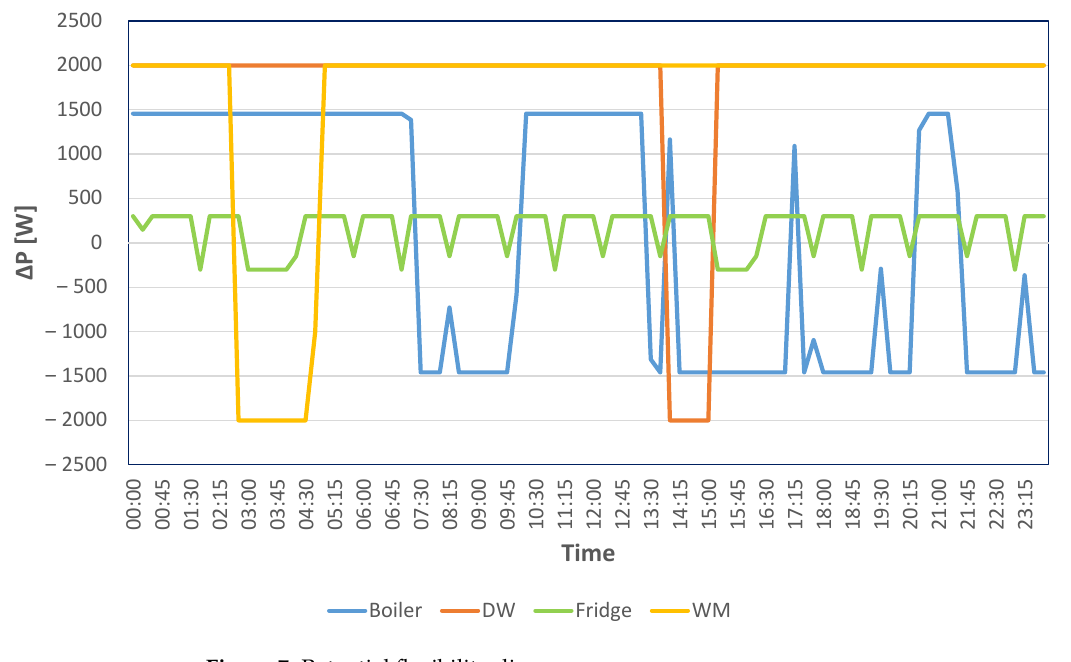
Figure 7. Potential flexibility diagrams.